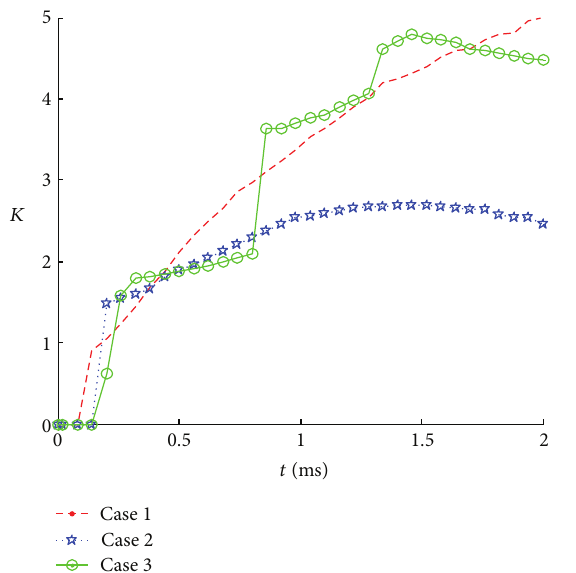
Figure 11: The crevasse radius of different covering thicknesses; 𝐶 is covering